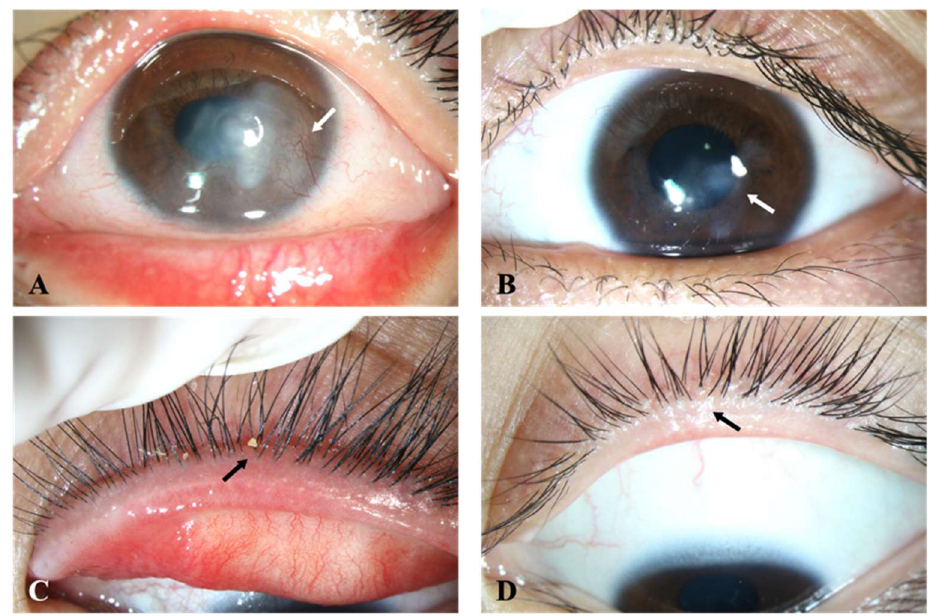
Figure 2. Changes in ocular signs before and after IPL treatment. ( A , B ) Severe corneal neovascularization (white arrow), conjunctival congestion and ( C , D ) eyelash scales (black arrow) had a marked improvement. Table 1. Patient data of ocular-surface indexes before and after treatment.